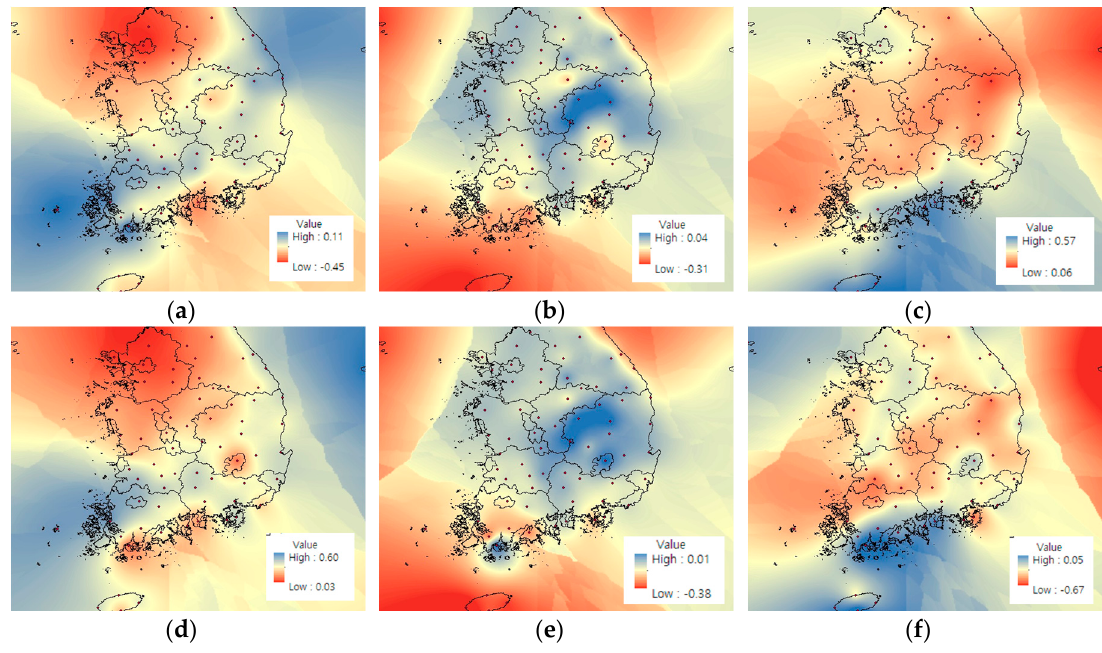
Figure 10. Distribution map of SPI and RDI from 2011 to 2100: ( a ) SPI from 2011 to 2040; ( b ) SPI from 2041 to 2070; ( c ) SPI from 2071 to 2100; ( d ) RDI from 2011 to 2040; ( e ) RDI from 2041 to 2070; ( f ) RDI from 2071 to 2100.